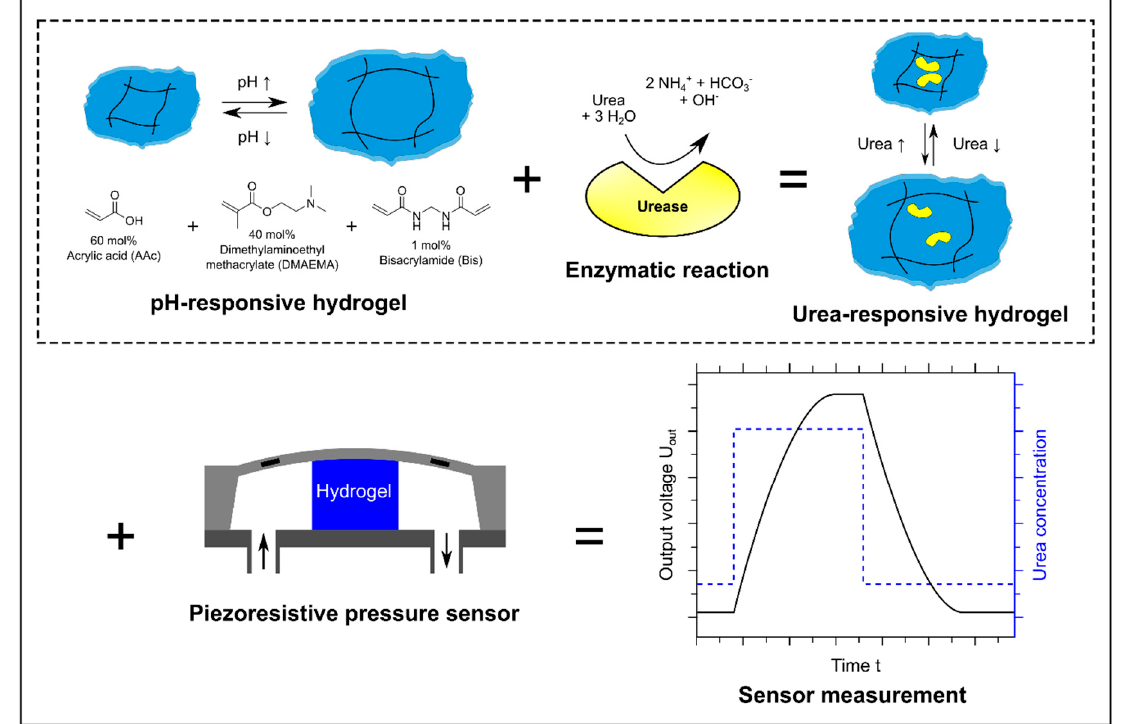
Figure 1. Measuring principle of a hydrogel-based urea biosensor: pH-responsive hydrogels based on acrylic acid (60 mol%) and dimethylaminoethyl methacrylate (40 mol%) are functionalized